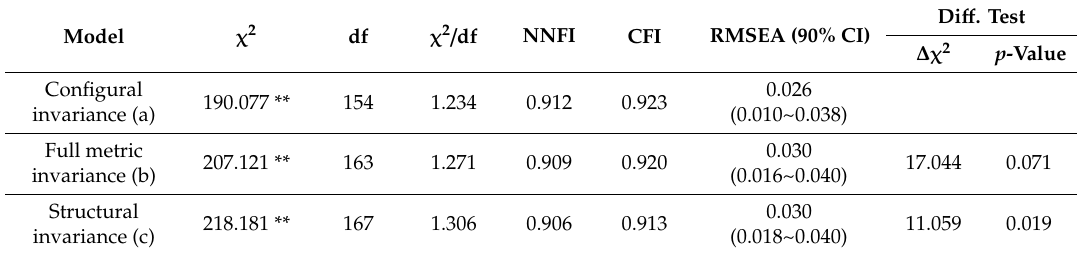
Table 11. Fit indices for invariance